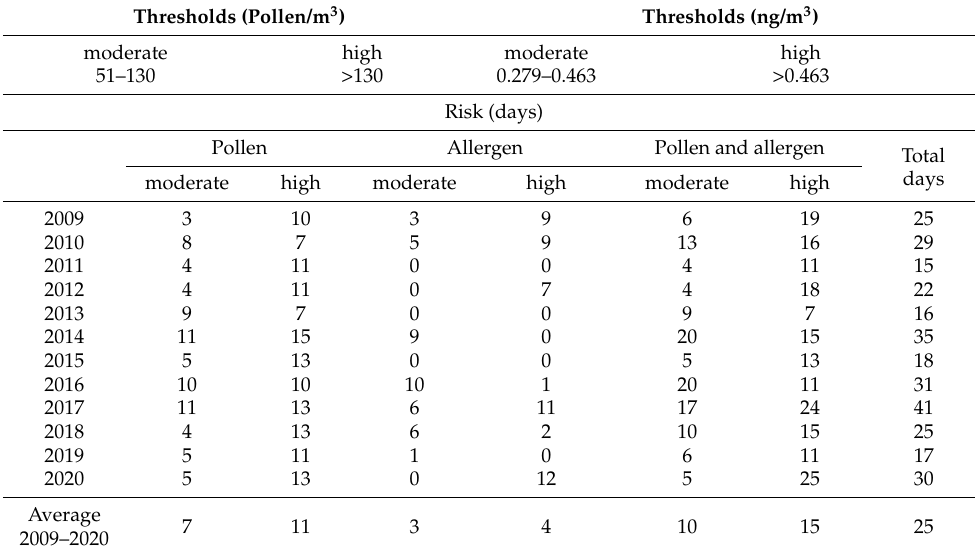
Table 2. Allergy risk periods for pollen and allergen thresholds.